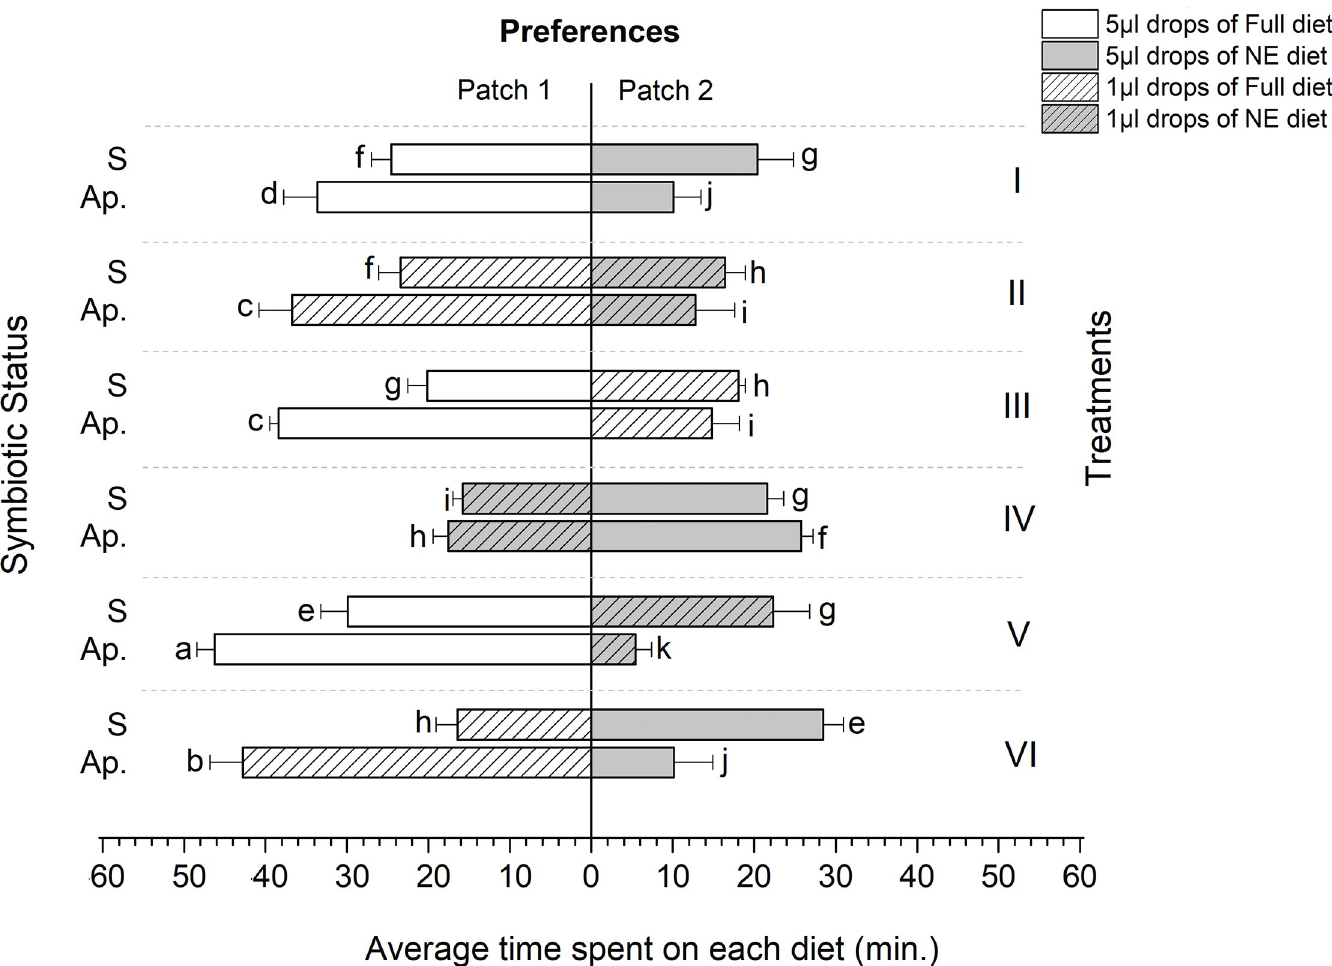
Fig 6. Feeding duration of Bactrocera dorsalis females under different foraging environments (Treatments). S: Symbiotic and Ap.: Aposymbiotic. Mean values followed by different letters are statistically different after Tukey HSD Test at P = 0.05.